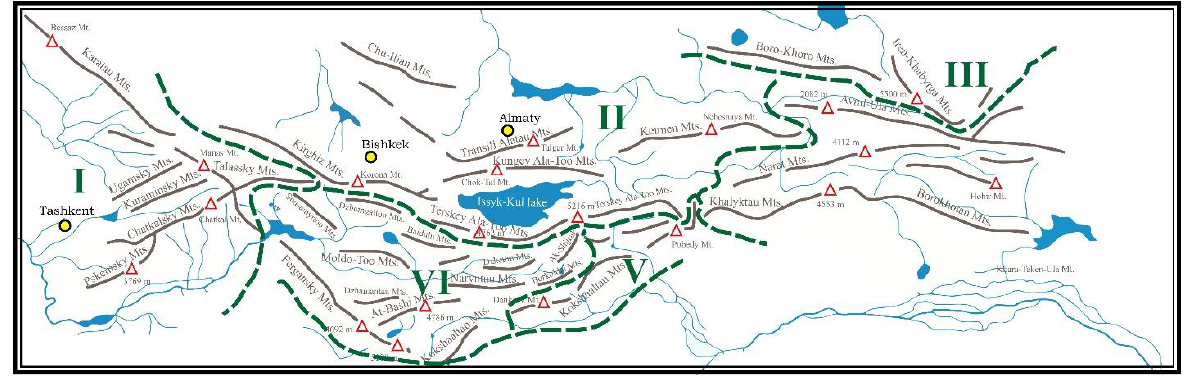
Fig. 1. Tian-Shan. I – West Tian-Shan, II – North Tian-Shan, III – Dzhungaria, IV – East Tian-Shan, V – Inner Tian-Shan, VI – Central